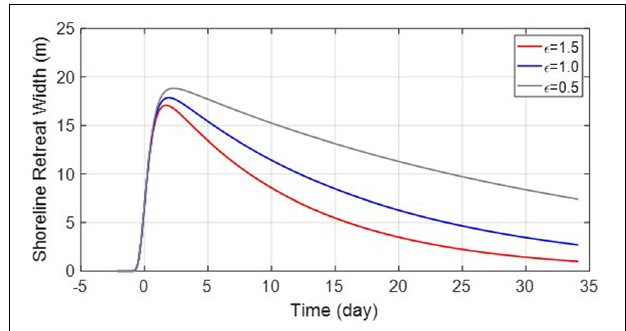
FIGURE 12 | SLRM result according to ε value ( H o p = 6 . 0 m and a r = 0 . 008